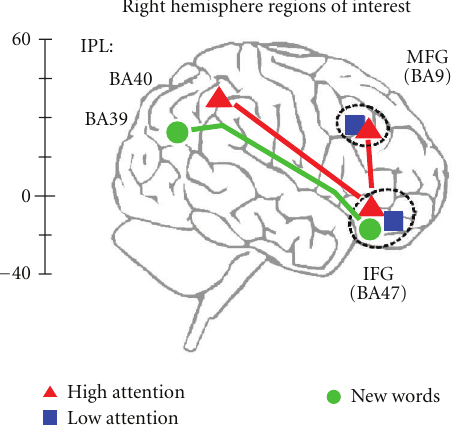
Figure 3: Neuroanatomical model of attentive listening networks in the right hemisphere. Both frontoparietal pathways belong to the proposed ventral, “bottom-up”, attention stream (see text). The top stream that processes High-Attention words (red pathway) connects BA40 in inferior parietal lobule (IPL) and BA47 in inferior frontal gyrus (IFG). The delayed-activation stream for novel stimuli (green pathway) shows the relationship between BA39 in IPL and BA47 in IFG. The red stream for processing High-attention words has another frontal component in right middle frontal gyrus (MFG) that appears to play a role in later postretrieval processing (see text). Responses to the Low-attention words were not observed in parietal cortex, but were present in BA9 and BA47, as well as in bilateral anterior insula (BA13) and dorsal anterior cingulate/supplementary motor area (BA6) (Table